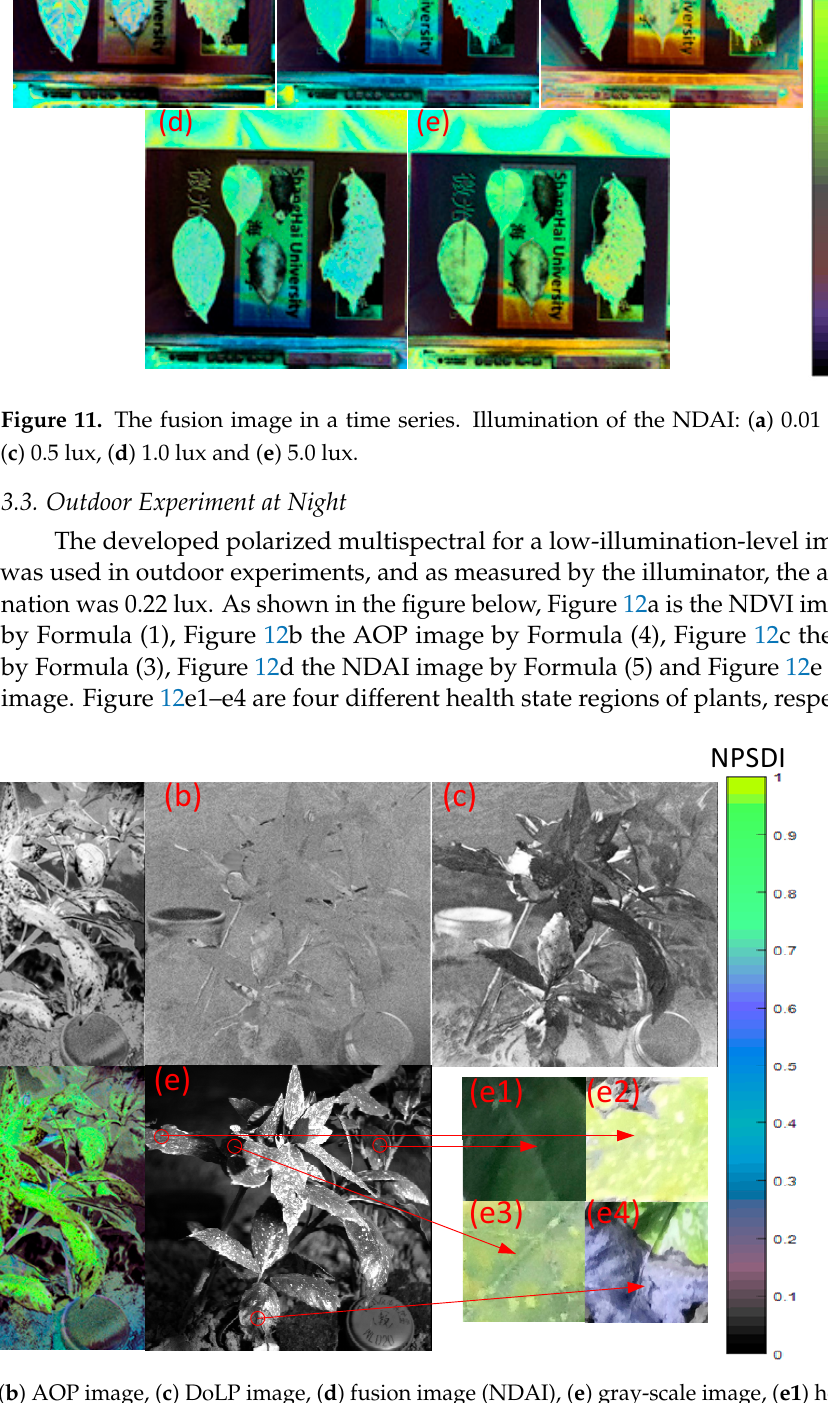
Figure 10. Vegetation index (NDVI) in a time series. Illumination of the NDVI: ( a ) 0.01 lux, ( b ) 0.1 lux, ( c ) 0.5 lux, ( d ) 1.0 lux and ( e ) 5.0 lux.